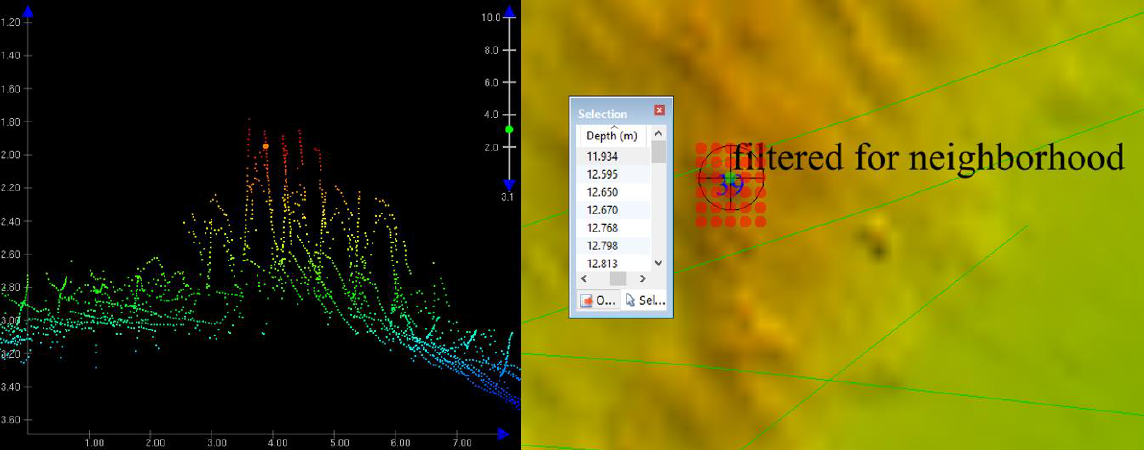
Figure 11. Example of Scan Designated output. The designated sounding appears less than 1 m off the seafloor when viewed in both sounding view (in the left pane) and grid data (in the right pane).